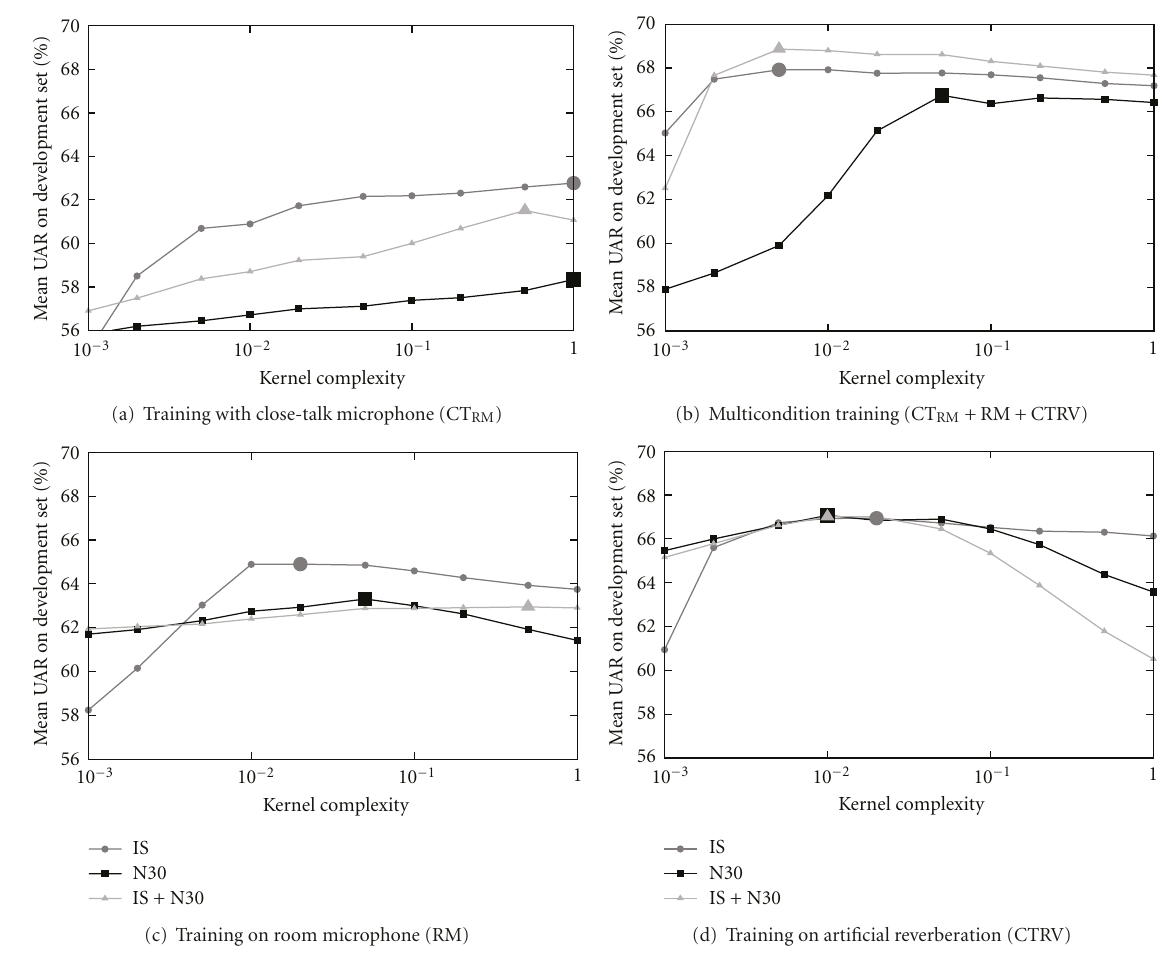
Figure 2: Optimization of the SMO kernel complexity parameter C on the mean unweighted average recall (UAR) on the development set of the FAU Aibo Emotion Corpus across the CT RM , RM, and CTRV conditions. For the experiments on the test set (Table 4), the value of C that achieved the best performance on average over all test conditions (CT RM , RM, and CTRV) was selected (depicted by larger symbols). The graphs for the N31 I and IS + N31 I sets are not shown for the sake of clarity, as their shape is roughly similar to N30 and IS +